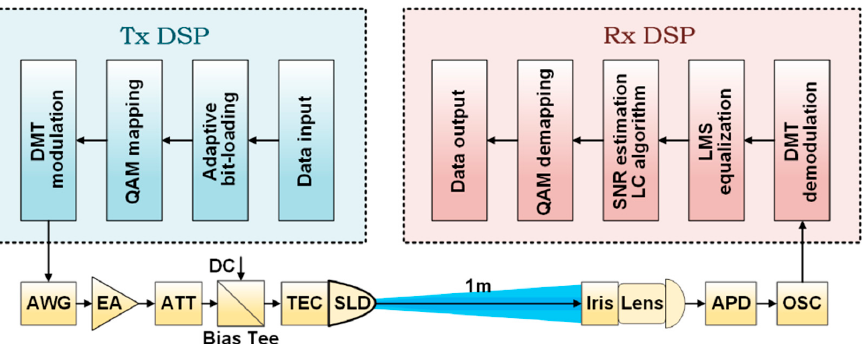
Figure 2. A diagram of blue SLD-based VLC system utilizing adaptive bit-loading DMT modulation